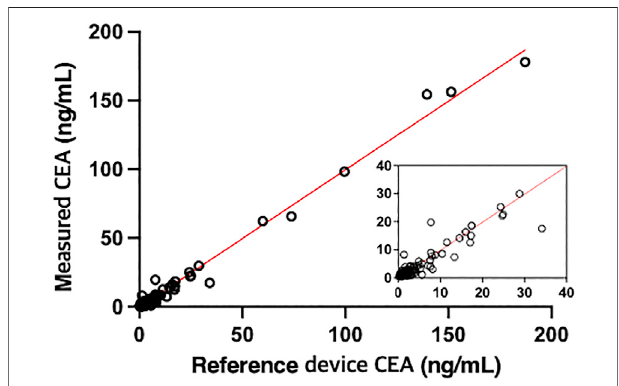
FIGURE4 | Comparison ofthe CEA valuesof 131samplesderived from patients measured by the proposed method with those measured by